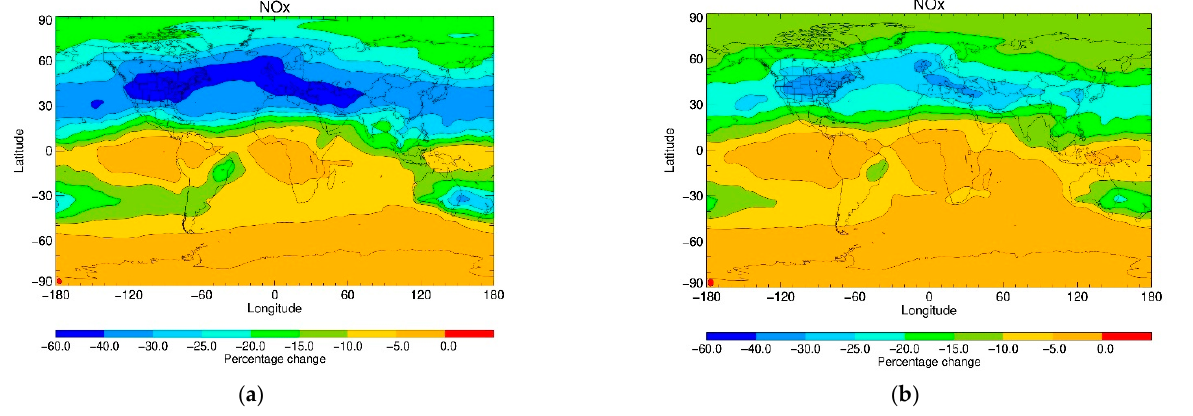
Figure 3. The percentage surface change of NO x mixing ratios at 11.8–16.2 km (201–100 hPa) from ( a ) STOCHEM-base to STOCHEM-75NO x scenario, ( b ) STOCHEM-base to STOCHEM-50NO x sce- nario.